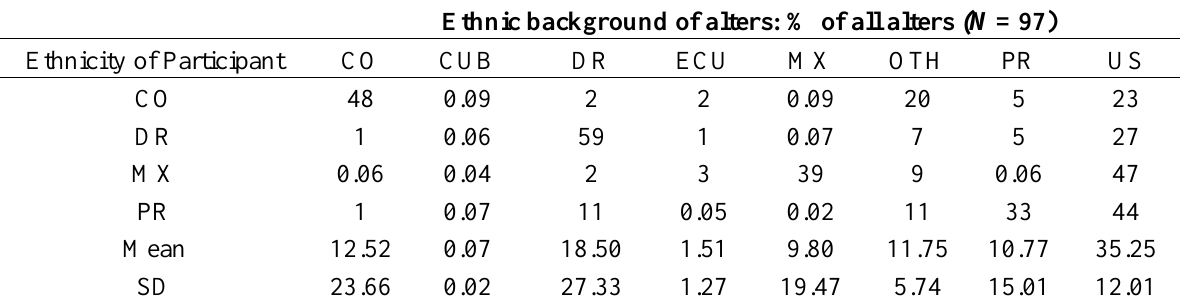
Table 6. Distribution of alters’ ethnic backgrounds for each ethnic group.